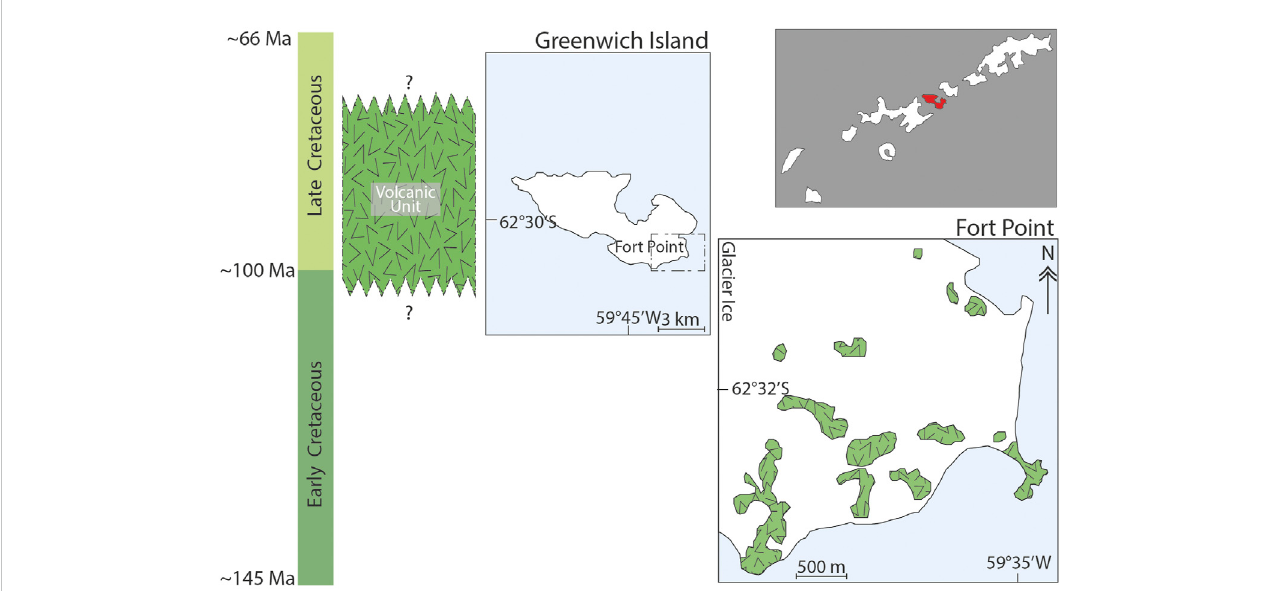
FIGURE 8 Geological map of Fort Point, Greenwich Island, from Machado et al. (2005).